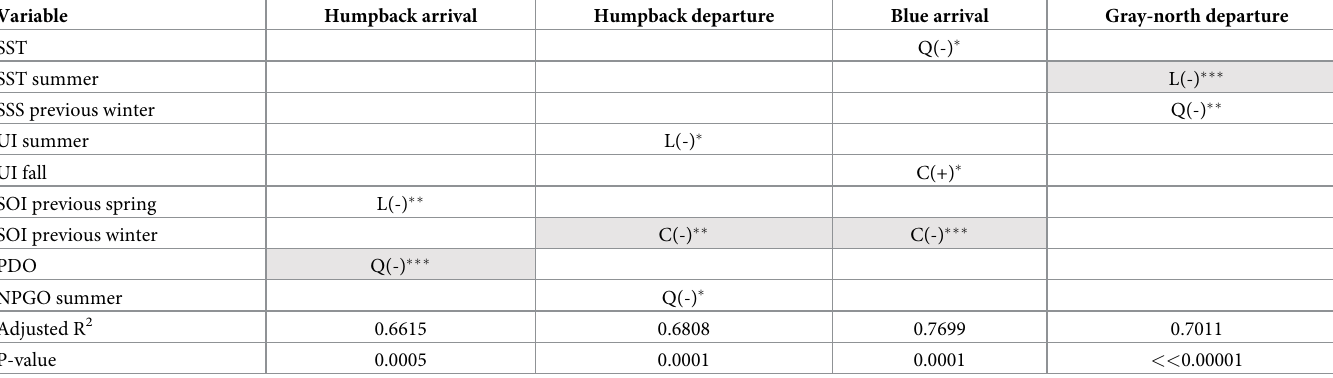
Models of blue departure, gray-north arrival, and both gray-south metrics were not significant (P > 0.05), and so are not shown. Relationships are depicted as linear (L), quadratic (Q), or cubic (C). The coefficients for the multivariable model were depicted as positive (+) or negative (-). The most dominant variables (see text) are shown in gray shading. The level of significance is depicted by ��� P �